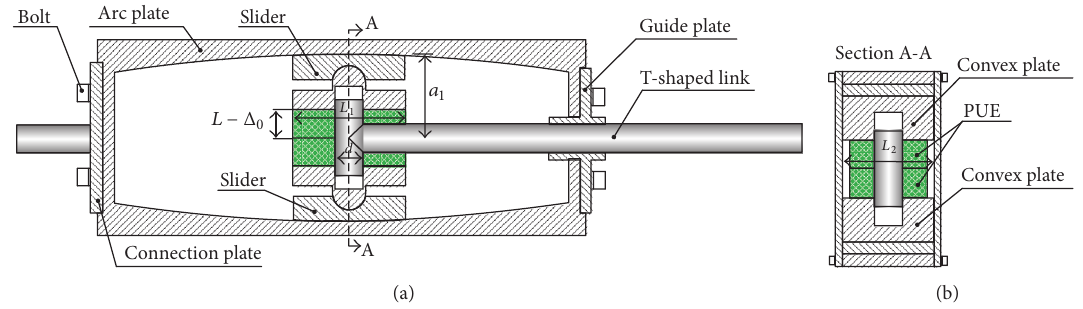
Figure 1: Schematic illustration of AFD: (a) longitudinal section and (b) cross section.